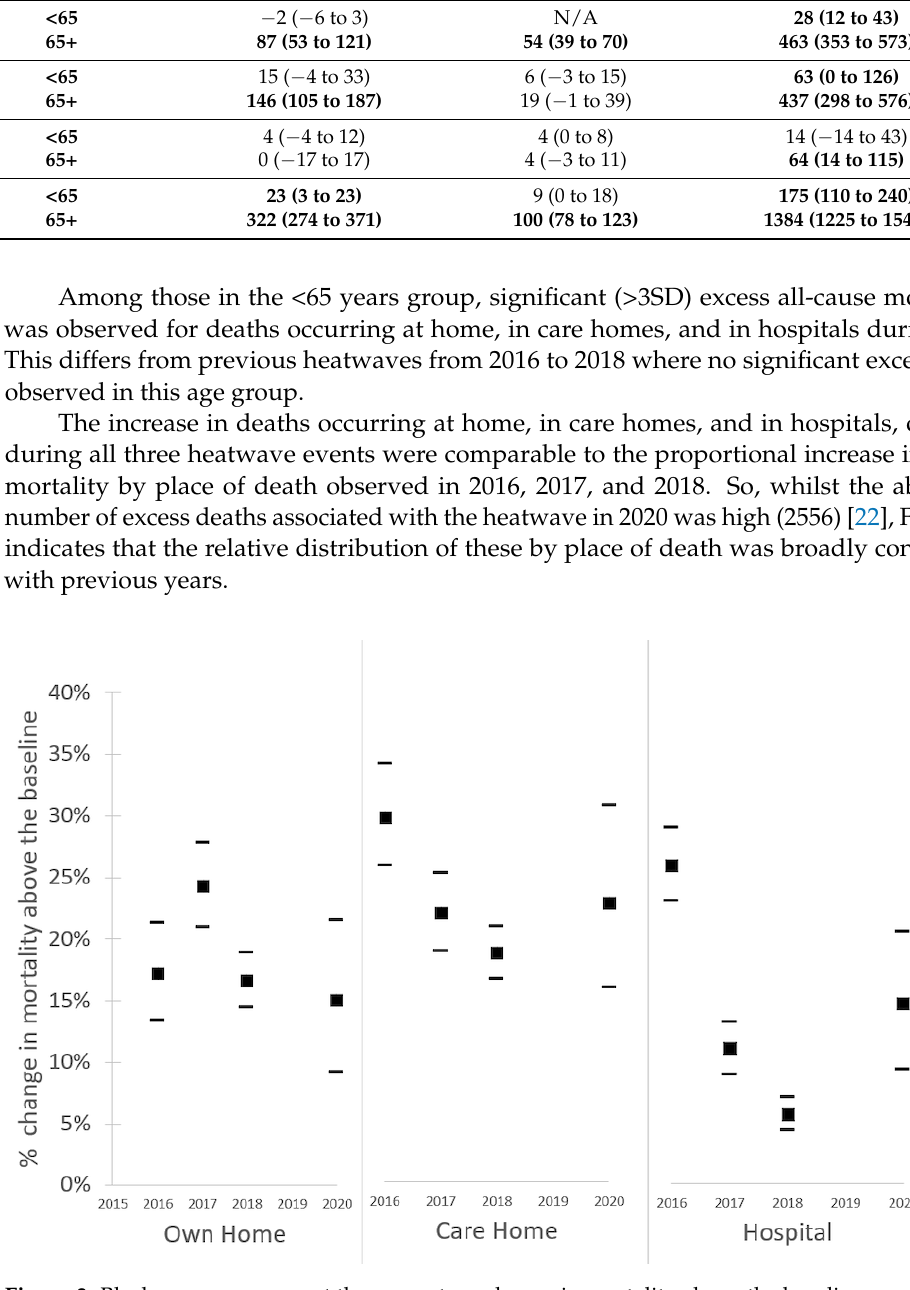
Figure 3. Black squares represent the percentage change in mortality above the baseline occurring at home, in care homes, and in hospitals during heatwave days compared to non-heatwave days for the years 2016, 2017, 2018, and 2020. Black dashes represent the calculated 95% confidence interval. Table 3. Estimated excess mortality for specific underlying causes of death by age group in England during three heatwaves in 2020. Bold values indicate all-cause excess mortality estimates considered to be statistically significant (above 3SD), with values within the brackets the 95% Confidence inter- vals. Heatwave1 (H1) occurred from 23 to 27 June affecting EM, WM, EoE, LON, SE, and SW; Heat- wave2 (H2) occurred from 30 July to 1 August. All regions affected; Heatwave3 (H3) occurred from 5 to 15 August affecting EoE, LON, and SE. Cause of Death